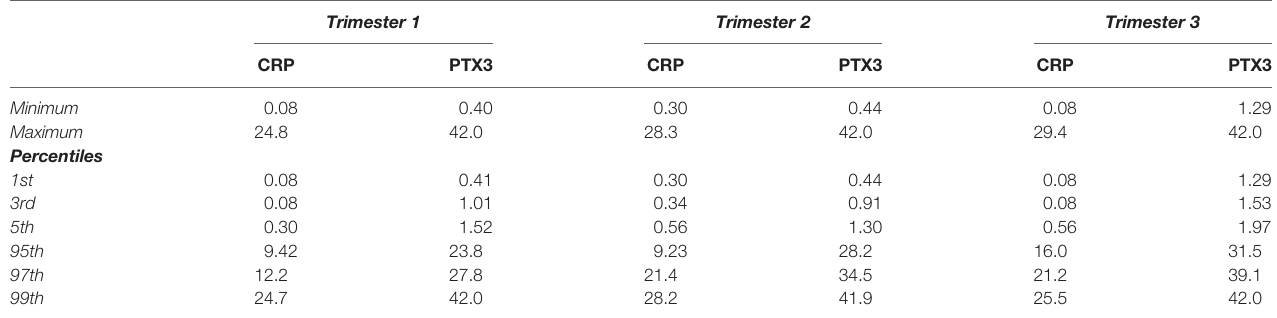
TABLE 2 | Pregnancy-speci fi c intervals for C-reactive protein (CRP, mg/L) and Pentraxin-3 (PTX3,